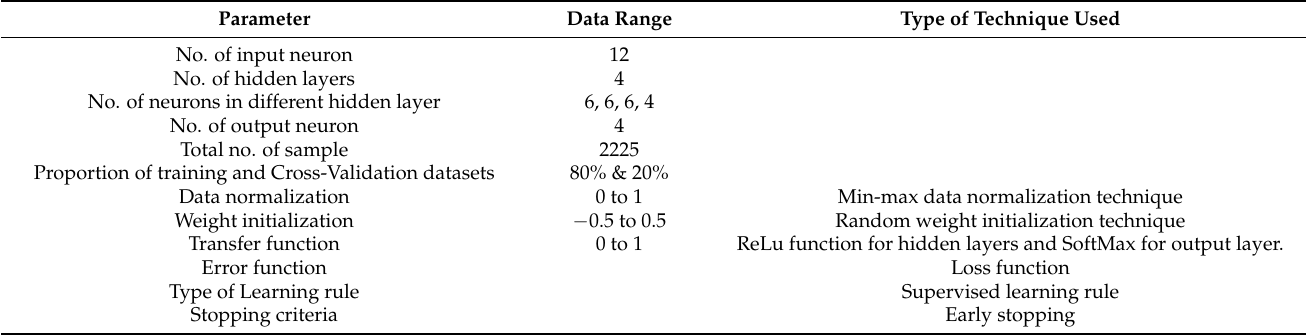
Table 3. Significant Measurement of parameters for NN